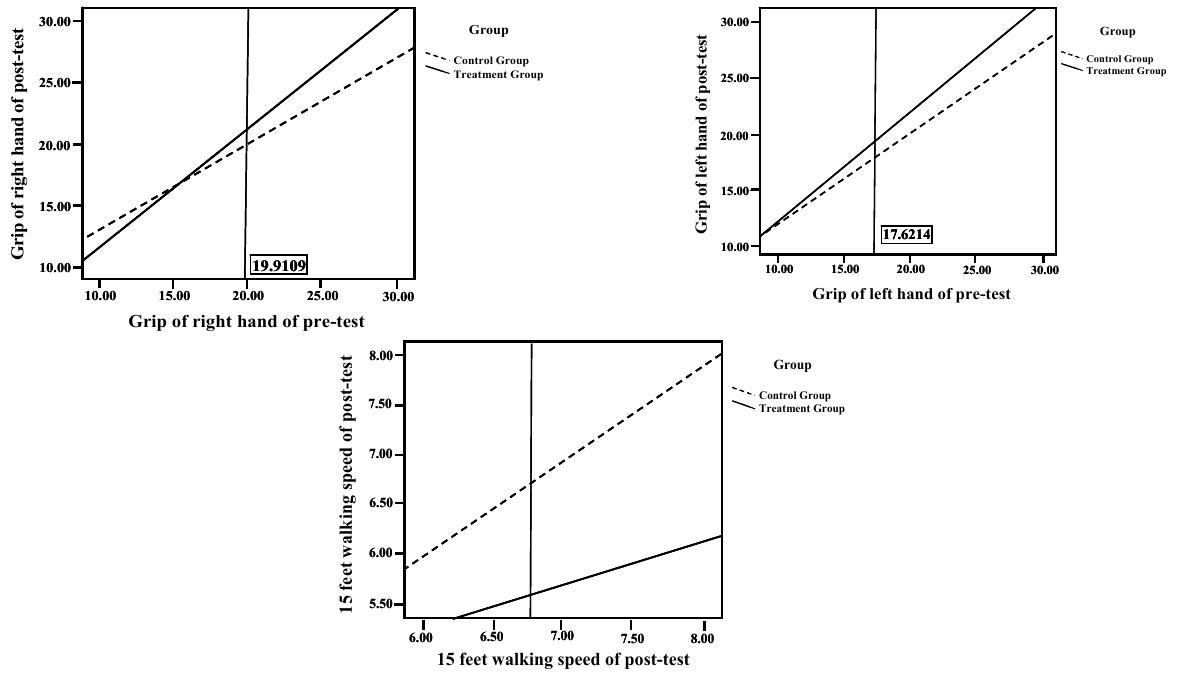
Figure 3. Sampling Procedure.